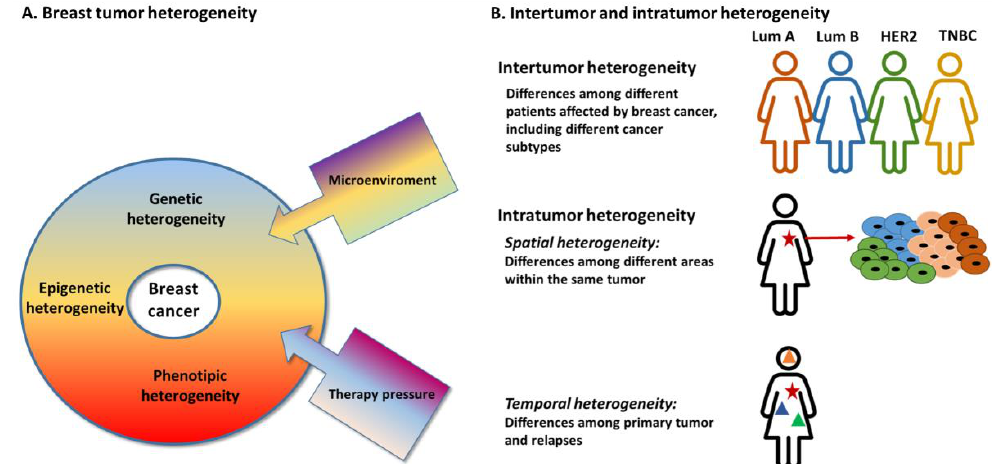
Figure 1. Breast tumor heterogeneity. ( A ) Factors that contribute to breast tumor heterogeneity; ( B ) Type of breast tumor heterogeneity: Inter-tumor and intra-tumor heterogeneity. Star: primary tumor, Triangles: relapses.